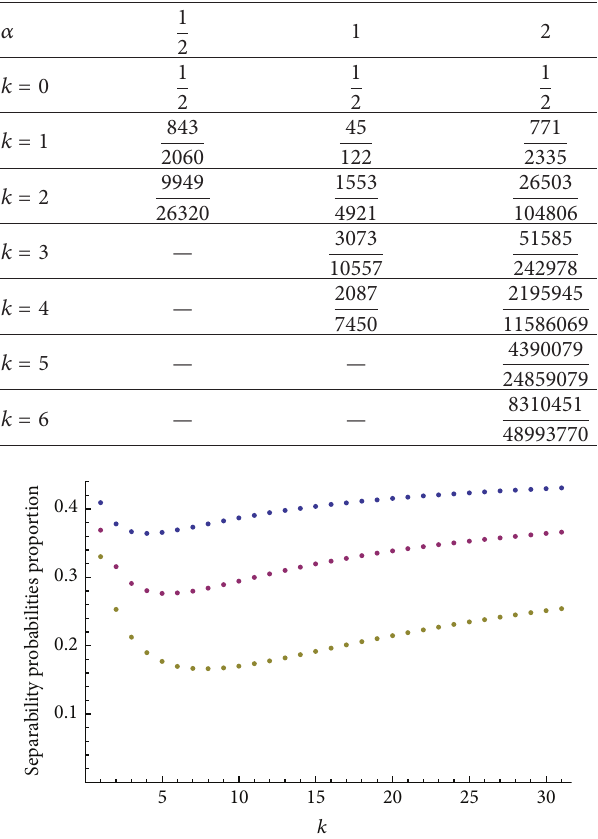
Figure 2: Proportion of the total random-induced separability probabilities, based on 9,201 moments, accounted for by the region |𝜌 PT | > |𝜌| . The two-rebit ( 𝛼 = 1 / 2) curve is dominant, the two- qubit ( 𝛼 = 1) is intermediate, and the two-quaterbit ( 𝛼 = 2) curve is